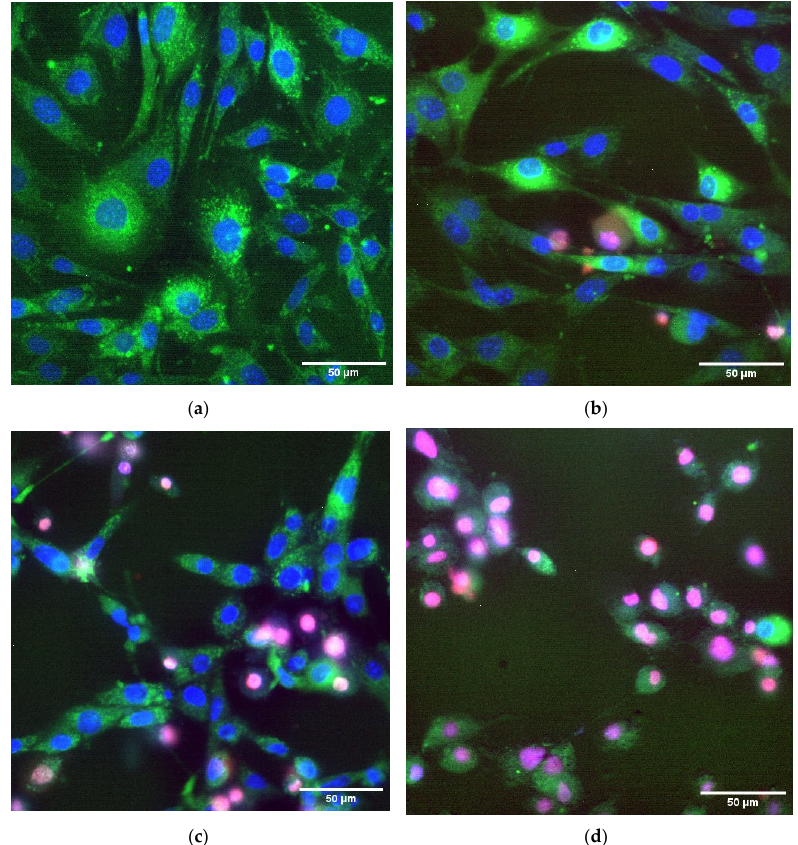
Figure 9. Representative images showing fibroblast cells at various concentrations of addition of iron oxide nanoparticles 24 h after exposure: ( a ) control cells, ( b ) cells with TSC-IONPs 5 × 10 12 mL − 1 , ( c ) cells with TSC-IONPs 7.5 × 10 12 mL − 1 , ( d ) cells with TSC-IONPs 10 13 mL − 1 . Staining with three types of fluorescent dyes: Hoechst 33342 (blue, stains the live cell nucleus), cell nuclei PI (red, stains the nucleus of dead cells), rhodamine-123 (green, mitochondrial membrane potential indi- cator). It turned out that in a wide range of concentrations up to 5 × 10 12 mL − 1 , NPs do not have a significant effect on cell viability (Figures 8 and 9). Further, the viability sharply decreases when TSC-IONPs are added. At 10 13 NPs concentrations, only a small per- centage of cells remains viable (2.1 ± 1.3%). For comparison, iron concentrations are shown below in Figure 8. The concentrations were calculated according to MADLS data (Figure 1) from the number of 10 nm NP aggregates, each of which contains approxi- mately 15 NPs 2.8 nm in diameter (Figure 2b). The area of cells increases (grows ~57% compared to control, statistically significant difference p < 0.01, t -test) up to the concentration of NPs 5 × 10 11 , and then decreases rel- ative to the control after TSC-IONP concentrations 7.5 × 10 12 (Figure 8). One-way ANO- VA showed statistical significance F (7, 111) = 9.86 with p << 0.001 in differences of the